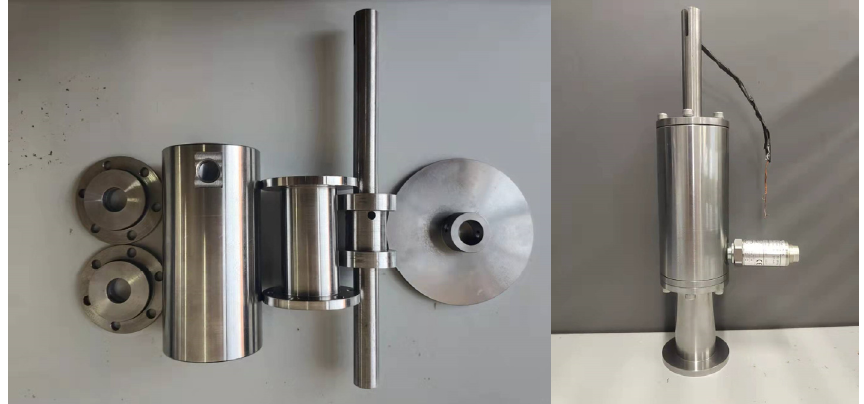
Figure 25. Prototype of double-rod magnetorheological damper.